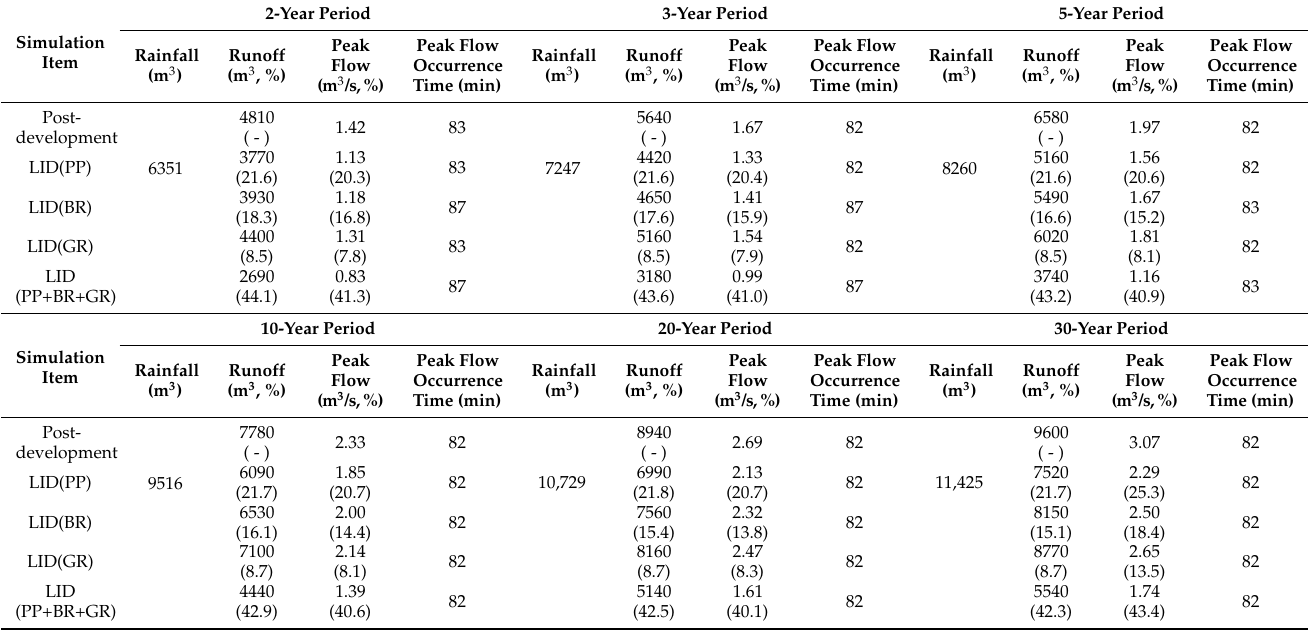
Table 13. Precipitation simulation results with various